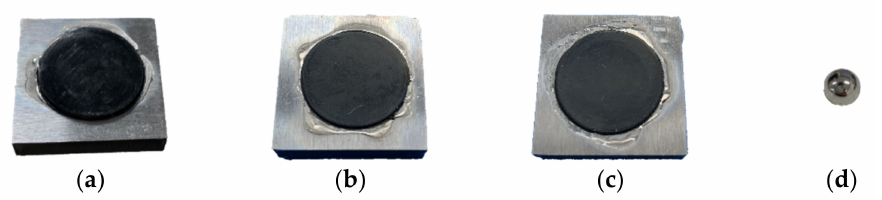
Figure 2. Fretting wear samples in the test: ( a ) EPDM; ( b ) FPM; ( c ) NBR; and ( d ) 304 stainless steel